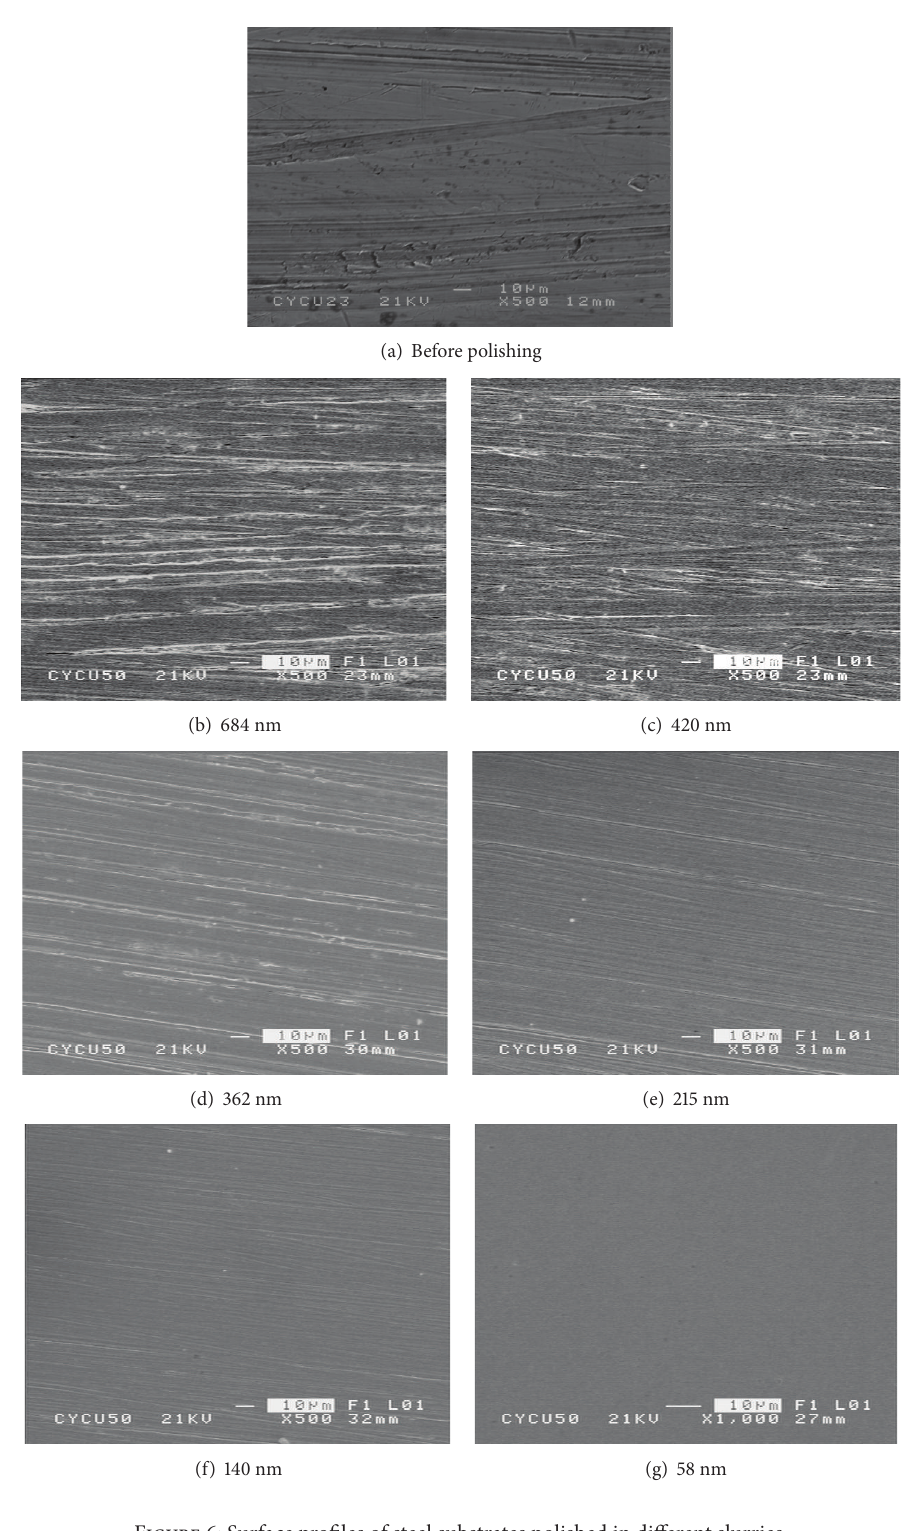
Figure 6: Surface profiles of steel substrates polished in different